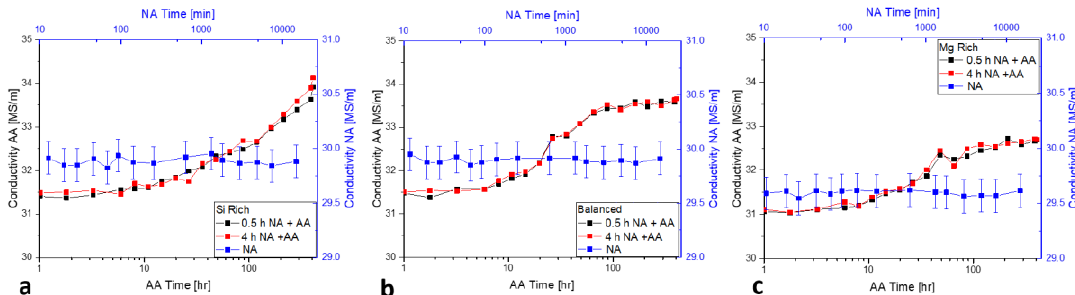
Figure 11. Conductivity evolutions during aging in the low strength alloys after WQ from ST, labelled accordingly. The primary axes correspond to AA (175 °C with 0.5 or 4 h prior NA), and the secondary axes correspond to NA itself (~21 °C). Error bars represent 95% confidence, and the discrepancy is due to the same reason as Figure 4.